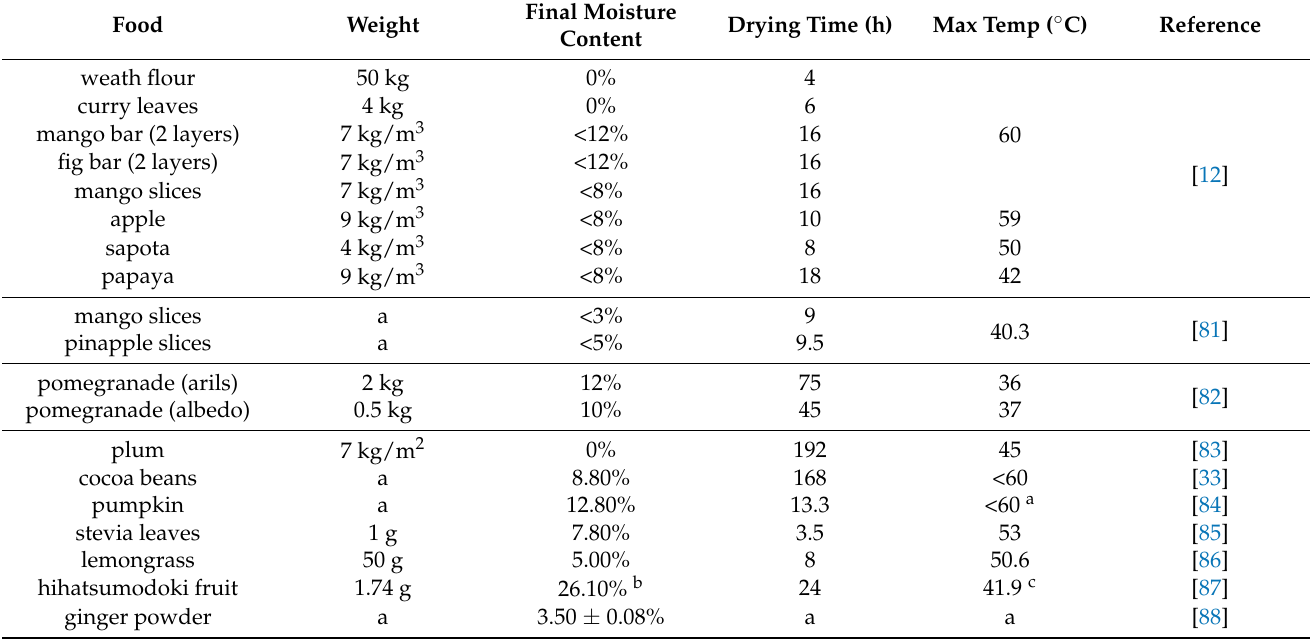
Table 2. Drying process on various food using solar